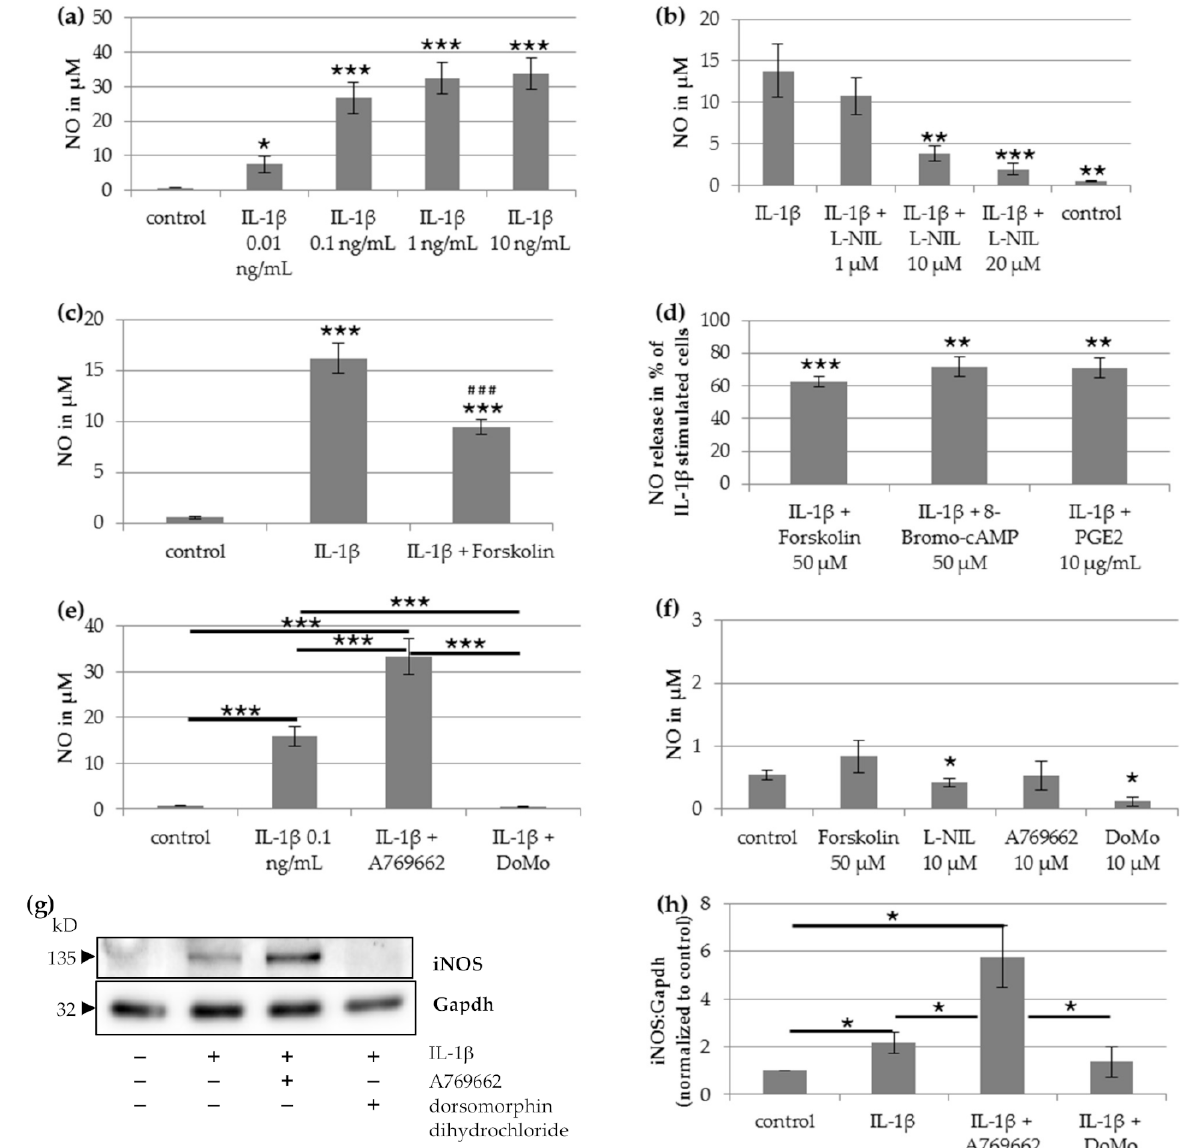
Figure 1. Impact of IL-1 β on nitric oxide (NO) release and NO synthase (iNOS) expression of human chondrocytes. ( a ) NO release after stimulation with Interleukin (IL)-1 β at different concentrations. Statistical differences vs. unstimulated cells, repeated-measures ANOVA ( n = 7). ( b ) NO release after stimulation with IL-1 β (0.1 ng/mL) and L-NIL at different concentrations. Statistical differences vs. IL-1 β -stimulated cells, repeated-measures ANOVA ( n = 7). ( c ) NO release after stimulation with 0.1 ng/mL IL-1 β and 50 µ M forskolin. Statistical differences *** vs. unstimulated cells or ### vs. IL-1 β -stimulated cells, Wilcoxon signed-rank test and Bonferroni adjustment ( n = 22). ( d ) NO release after simultaneous stimulation of 0.1 ng/mL IL-1 β with 50 µ M forskolin ( n = 22), 50 µ M 8-Bromo-cAMP ( n = 10), or 10 µ g/mL PGE 2 ( n = 9) normalized to IL-1 β -stimulated cells. Statistical differences vs. IL-1 β -stimulated cells, Wilcoxon signed-rank test. ( e ) Impact of activation or inhibition of AMPK on IL-1 β -induced NO release. Statistic: Repeated-measures ANOVA with Post Hoc test and Bonferroni adjustment ( n = 9). ( f ) NO release after stimulation with 50 µ M forskolin, 10 µ M L-NIL, 10 µ M A769662, or 10 µ M dorsomorphin dihydrochloride (DoMo). Statistical differences vs. unstimulated cells, Wilcoxon signed-rank test ( n = 5). ( g ) Representative Western blot of iNOS expression after stimulation with/without 0.1 ng/mL IL-1 β , 50 µ M forskolin, 10 µ M A769662 and 10 µ M dorsomorphin dihydrochloride. ( h ) Densitometric quantification of iNOS/Gapdh expression after stimulation with 0.1 ng/mL IL-1 β , 10 µ M A769662 or 10 µ M dorsomorphin dihydrochloride normalized to unstimulated cells ( n = 6). Statistic: Wilcoxon signed-rank test. Values are reported as mean or percentage ± SD. *** p < 0.005, ** p < 0.01 and * p < 0.05. DoMo: Dorsomorphin